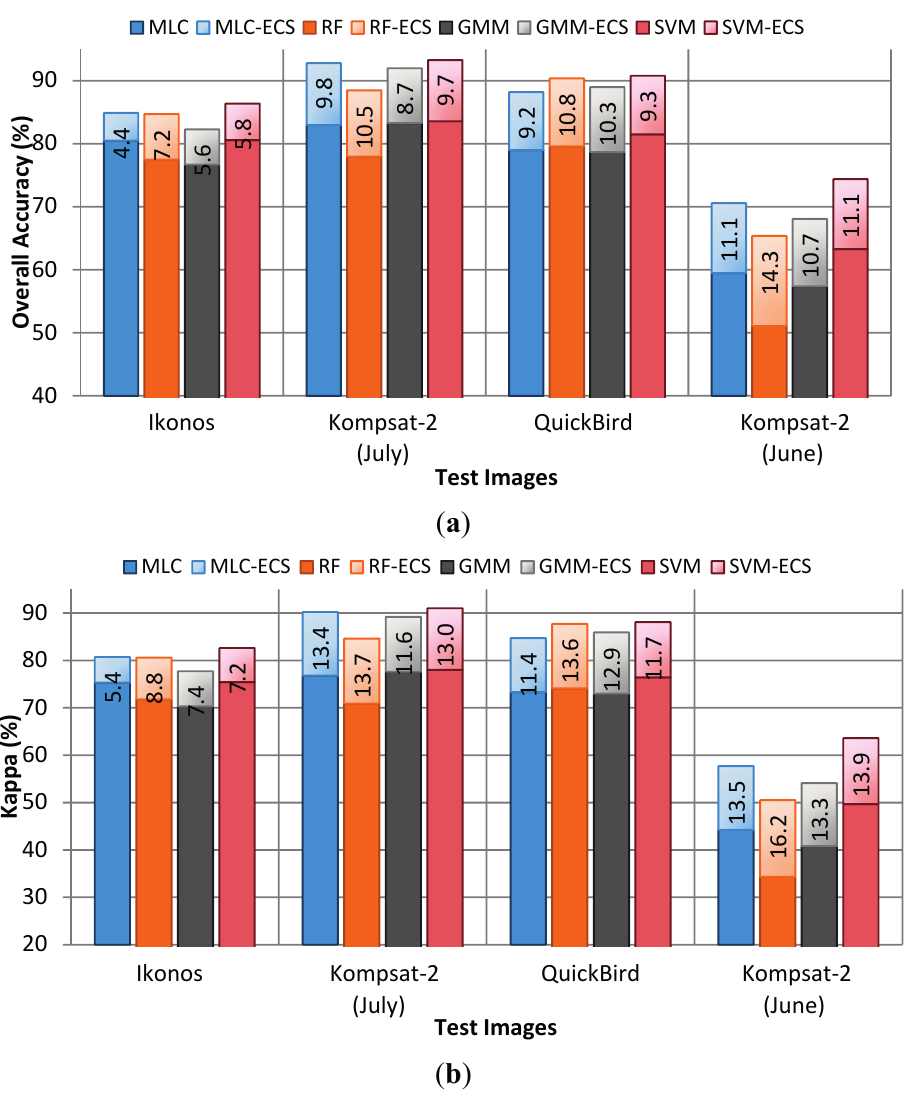
Figure 5. Performance improvements after CRF exponential smoothing. ( a ) Overall accuracies, and ( b ) kappa